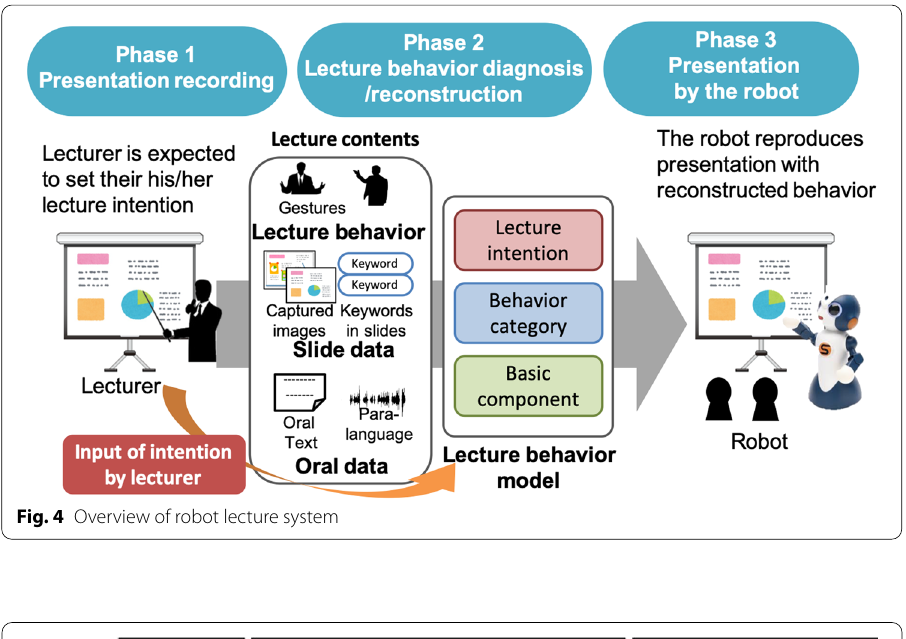
Fig. 4 Overview of robot lecture system